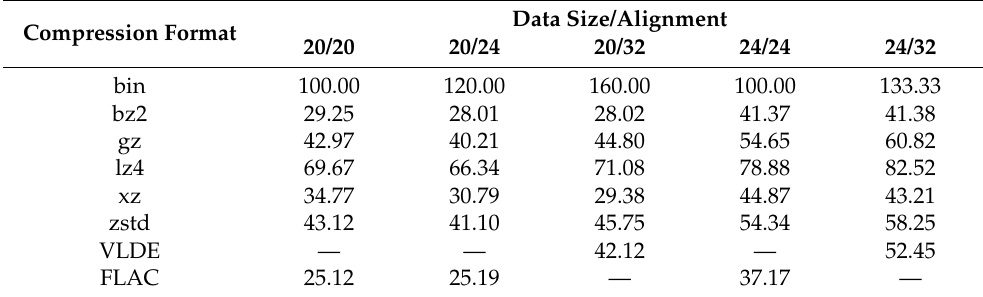
Table 2. Off-line data compression ratio for different compression algorithms and bit depths, applied to the differentiated signal. Columns represent different data size/alignment options.